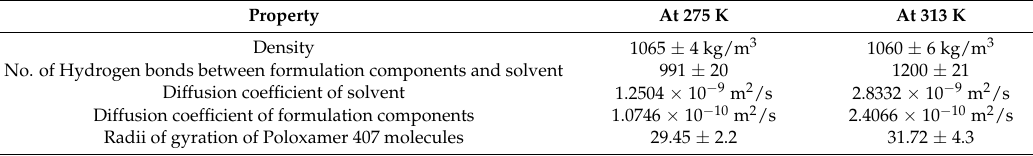
Figure 7. Effect of temperature on the specific volume of the simulation box containing formulation components and water. Table 5. Physical properties of the formulation in both sol at 275 K (1.85 ◦ C) and gel phase at 313 K (39.85 ◦